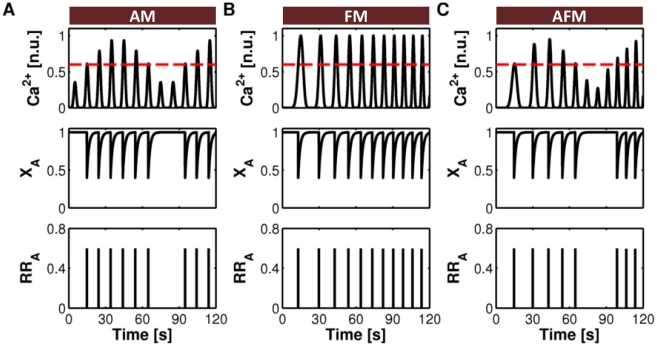
Different Ca2+ patterns trigger glutamate release from the astrocyte at different frequencies.Fast reintegration of released glutamate and low-frequency Ca2+ oscillations translate (A) AM, (B) FM and (C) AFM Ca2+ dynamics (top) into different frequency-modulated sequences of glutamate release events (GREs) from the astrocyte (middle), all of equal magnitude (bottom). Parameters as in Table S1.